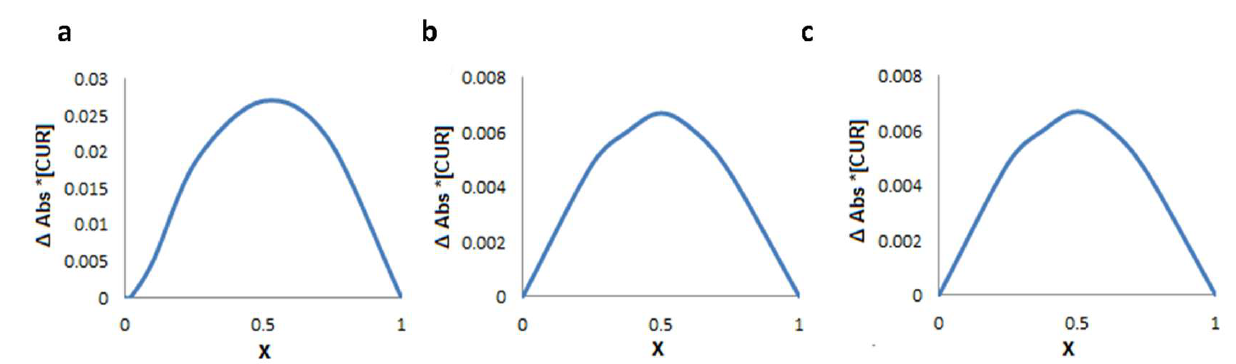
Figure 5. Job’s plots for ( a ) CUR-γCD-NH 2 , ( b ) CUR-γ-CD-CD-NHCH 2 CH 2 NH 2 , and ( c ) CUR-γ-CD-NHCH 2 CH 2 OH, where X is the mole fraction of CUR.